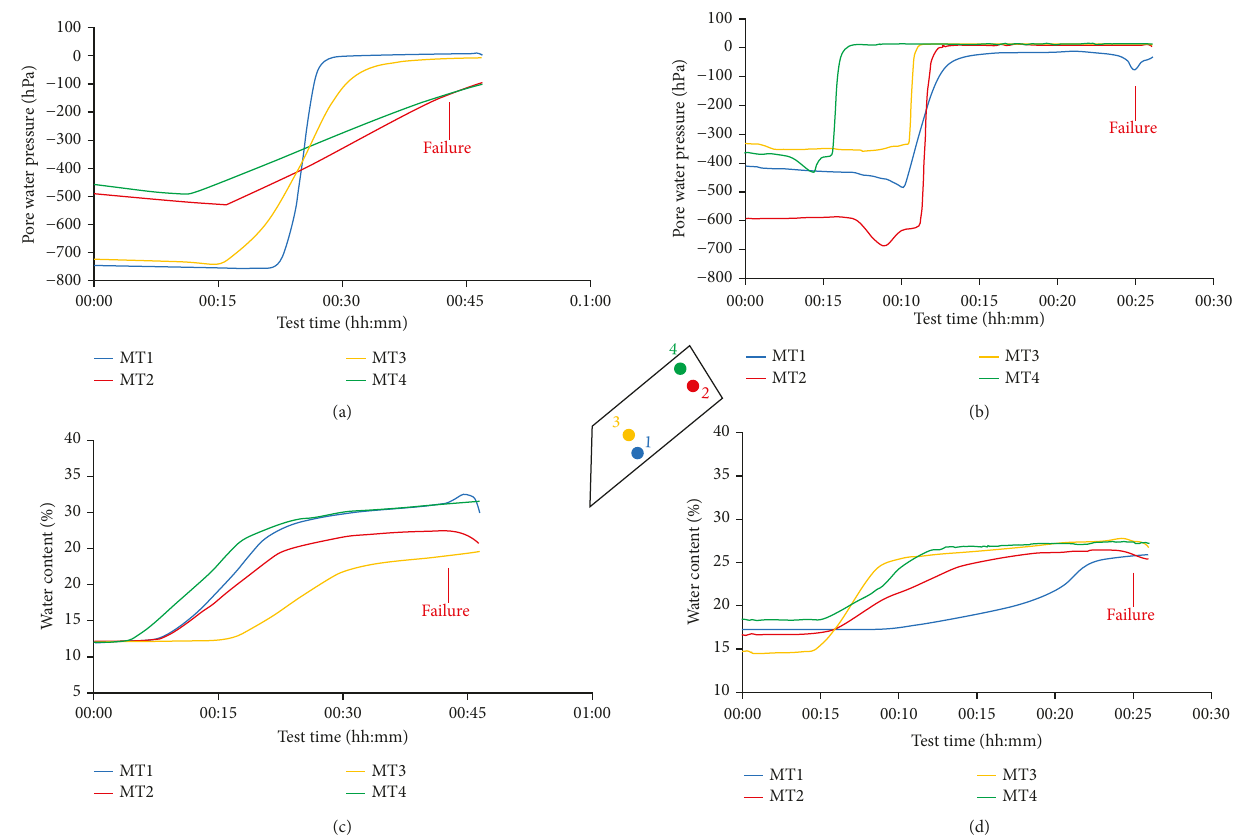
Figure 9: Pore water pressure (a and b) and soil moisture data (c and d) recorded during test n.6 ( α = 35 ° , w = 11 9% ) and test n.8 ( α = 35 ° , w = 16% ), respectively.